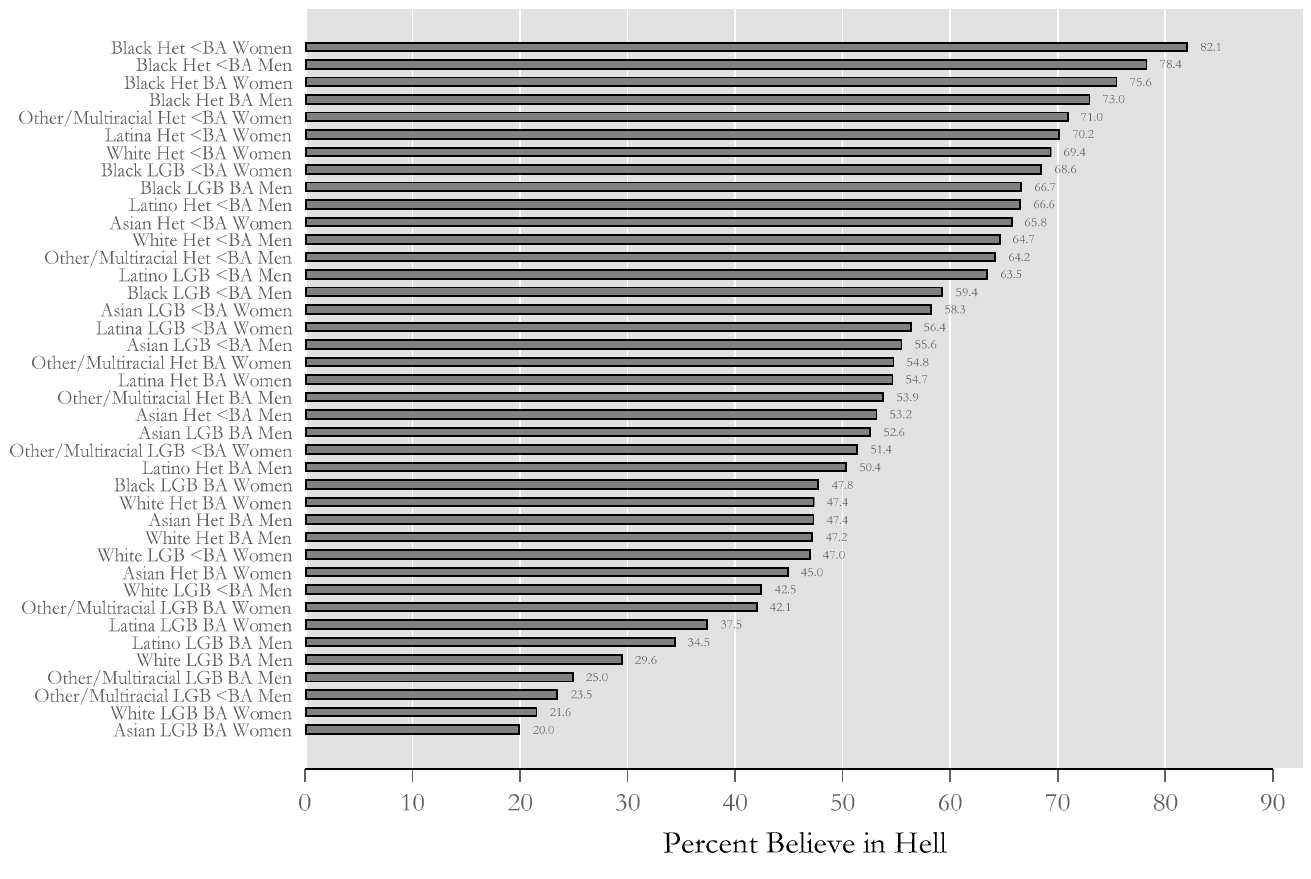
Figure A5. Belief in Hell, RLS (N = 30,672).